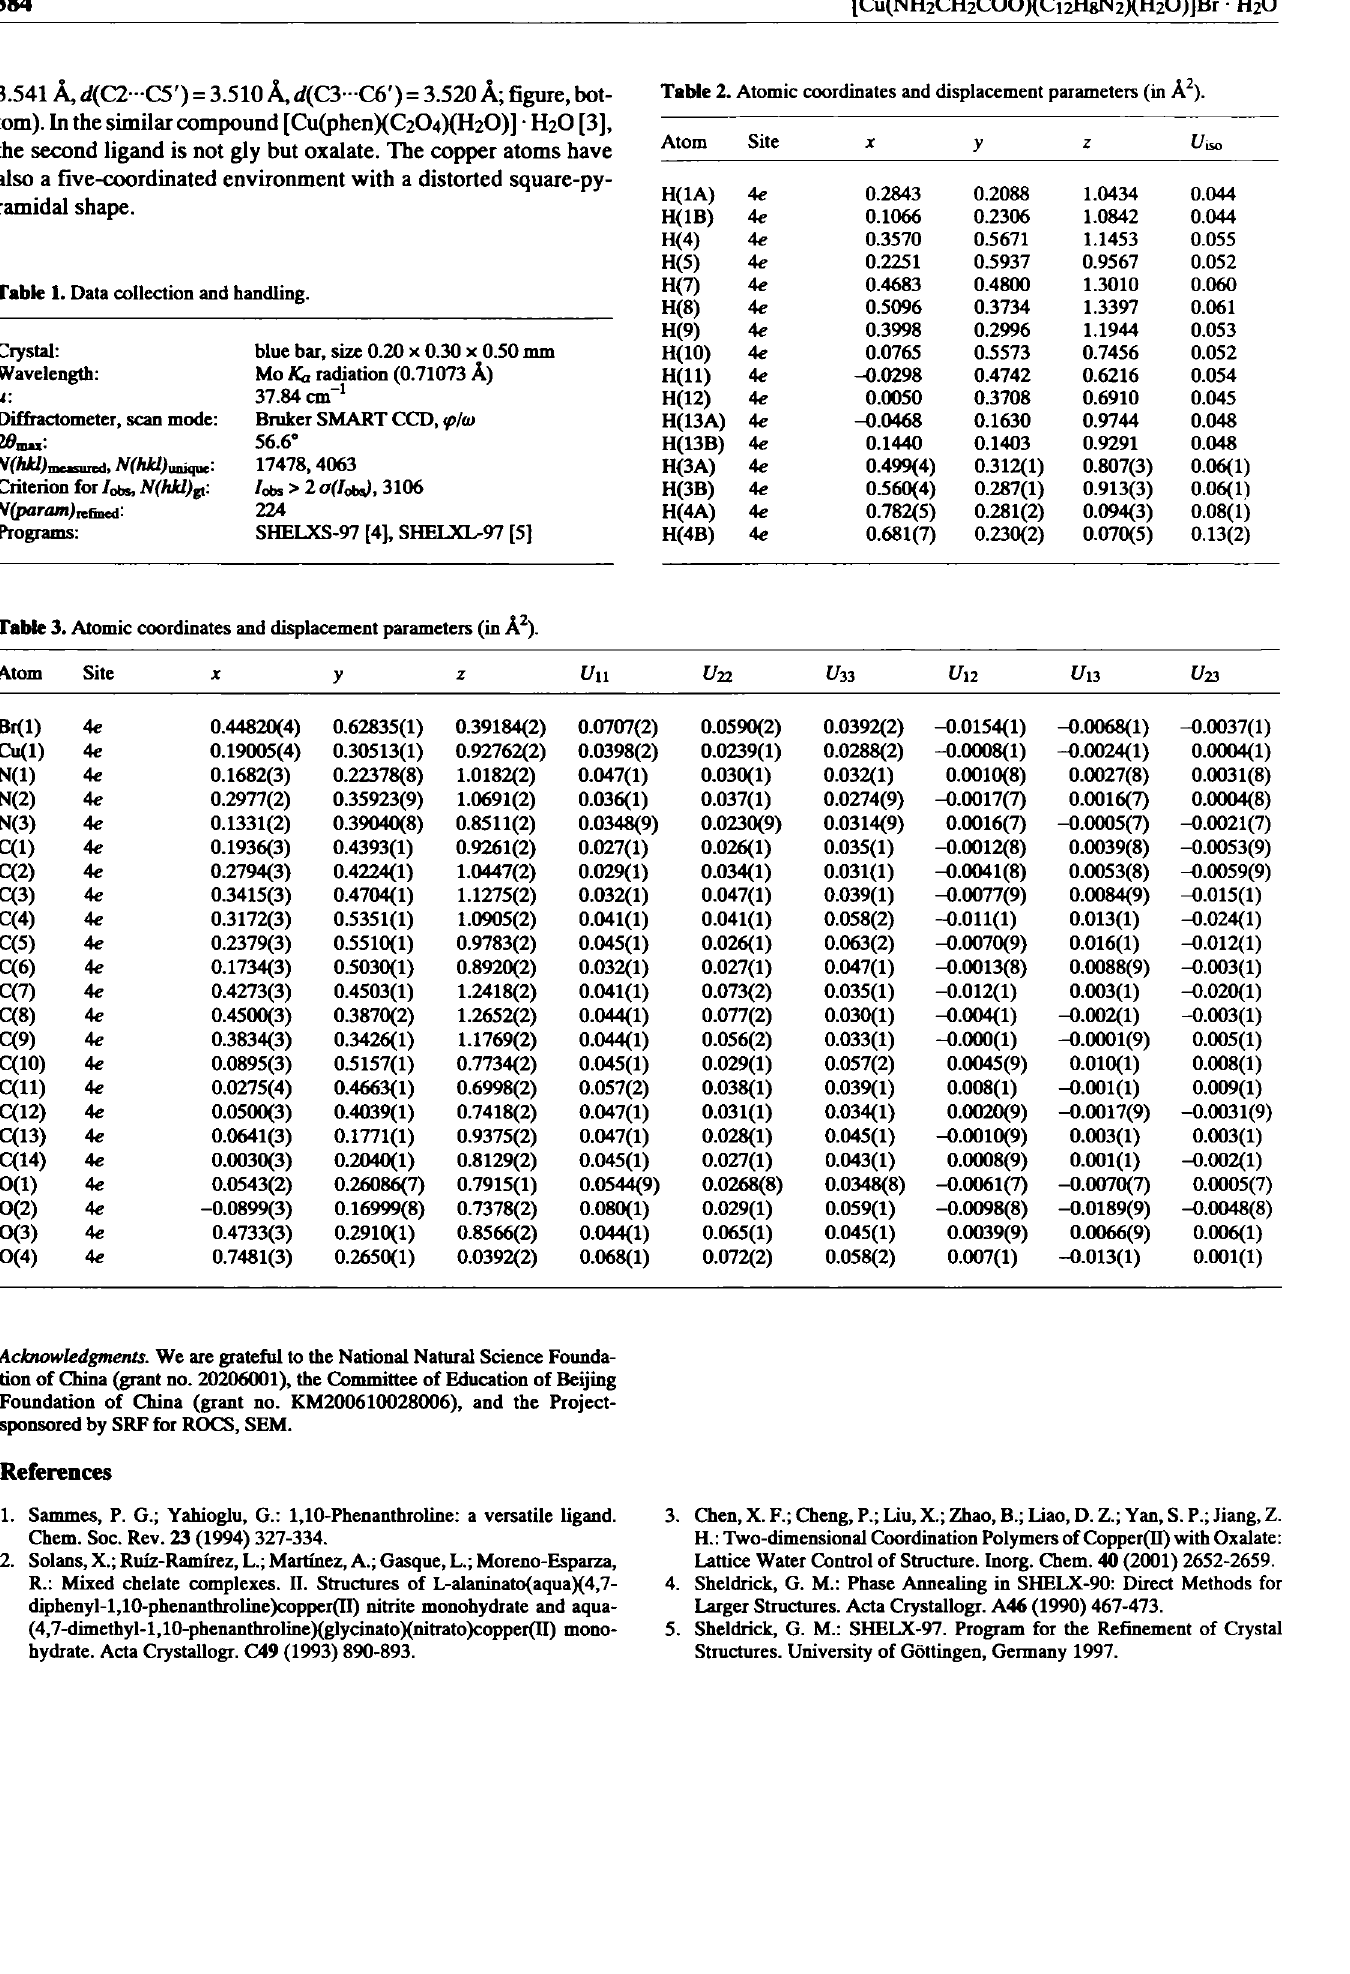
Table 2. Atomic coordinates and displacement parameters (in A 2 ).